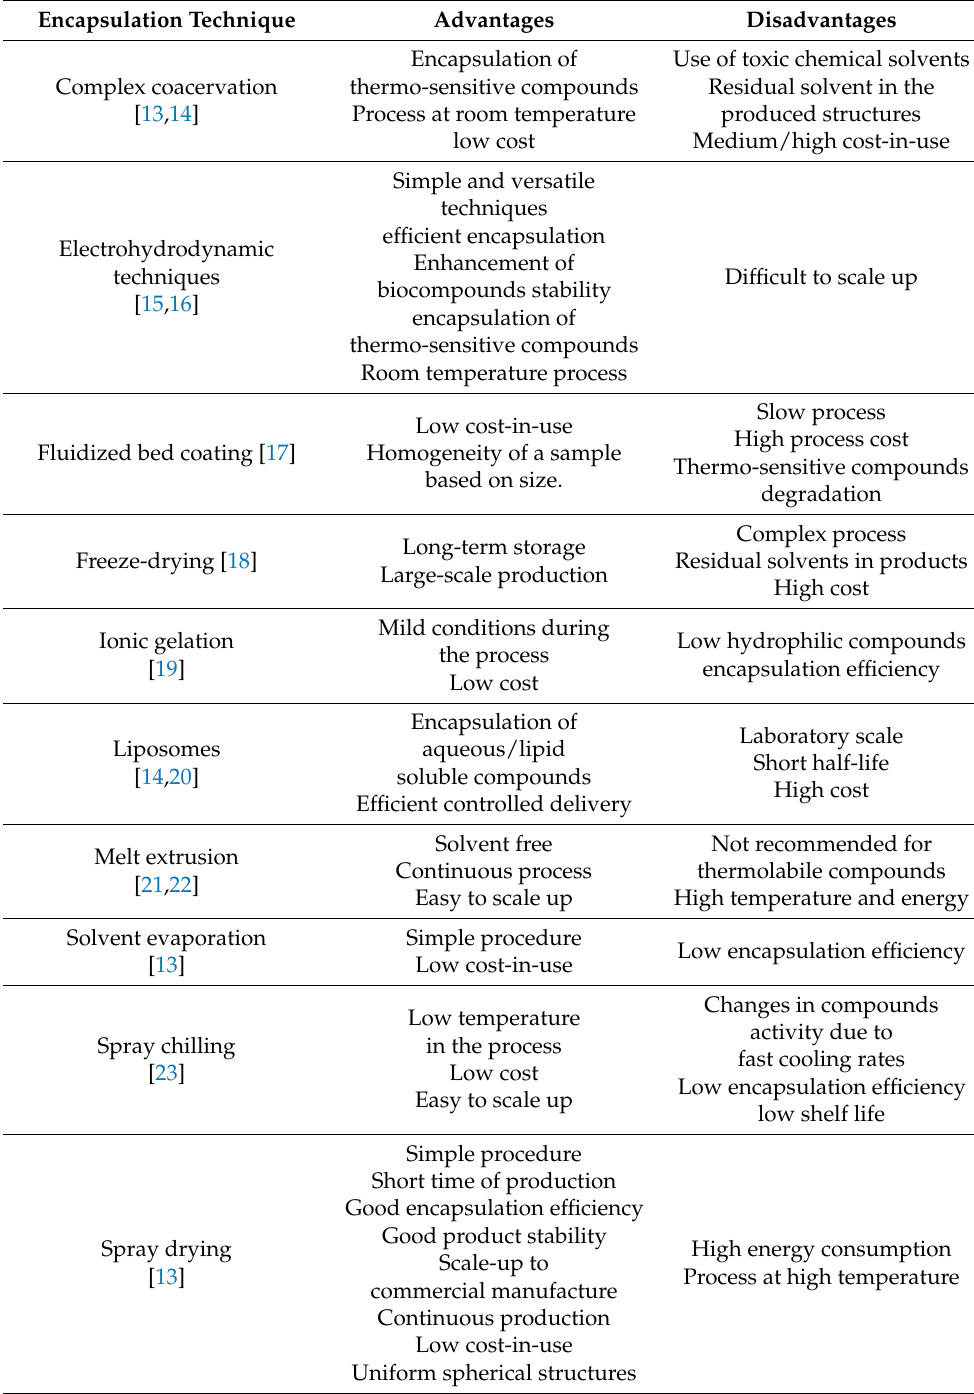
Table 2. Advantages and disadvantages of most common techniques used in food